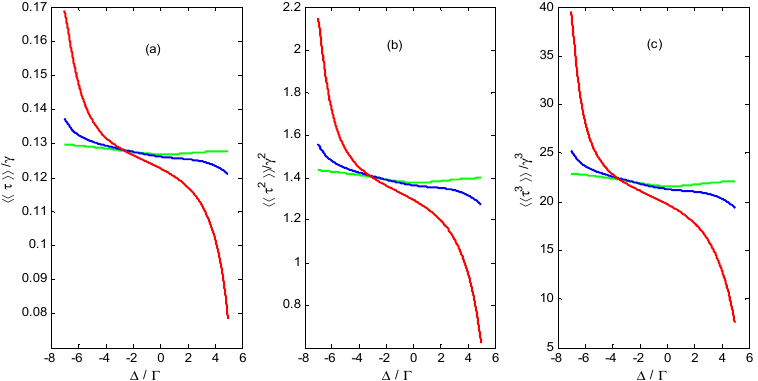
Figure 3. ( a ) waiting time distribuitions (WTDs) as a function of waiting time τ for di ff erent parameters. ∆ = − 7 Γ (blue line); ∆ = − 4 Γ (green line); ∆ = 5.5 Γ (red line); cavity without DQDs (black line); DQDs replaced by thermal bath γ h = 0.02, n h = 10 (cyan), thermal bath γ h = 0.02, n h = 0 (magenta); γ = 0.02, n = 1, Γ = 1, ω Γ , η = 0.05, Ω = 7 Γ ; ( b ) the same curves as ( a ) on a logarithmic scale. m = 10 0